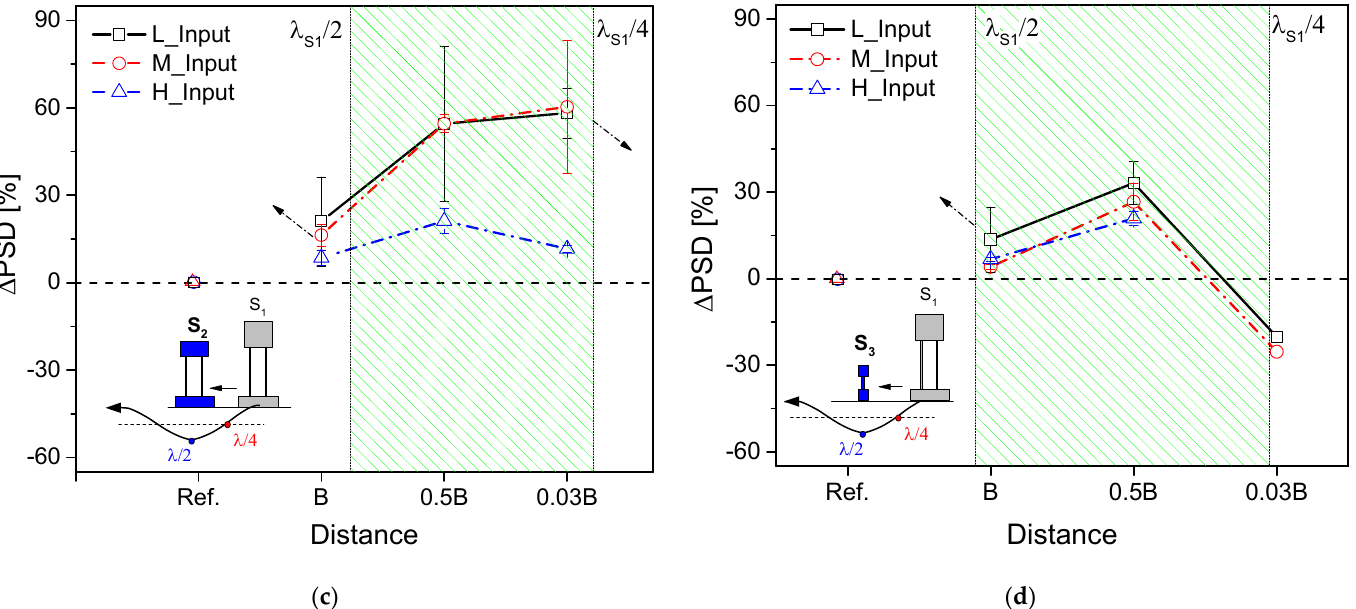
Figure 9. Variation of ΔPSD with distance between foundations ( a ) for S1 structure in adjacent to S2 structure in S1‐S2 case; ( b ) for S1 structure adjacent to S3 structure in S1‐S3 case; ( c ) for S2 structure in S1‐S2 case; ( d ) for S3 structure in S1‐S3 case. λ is wavelength emitted from adjacent structure.